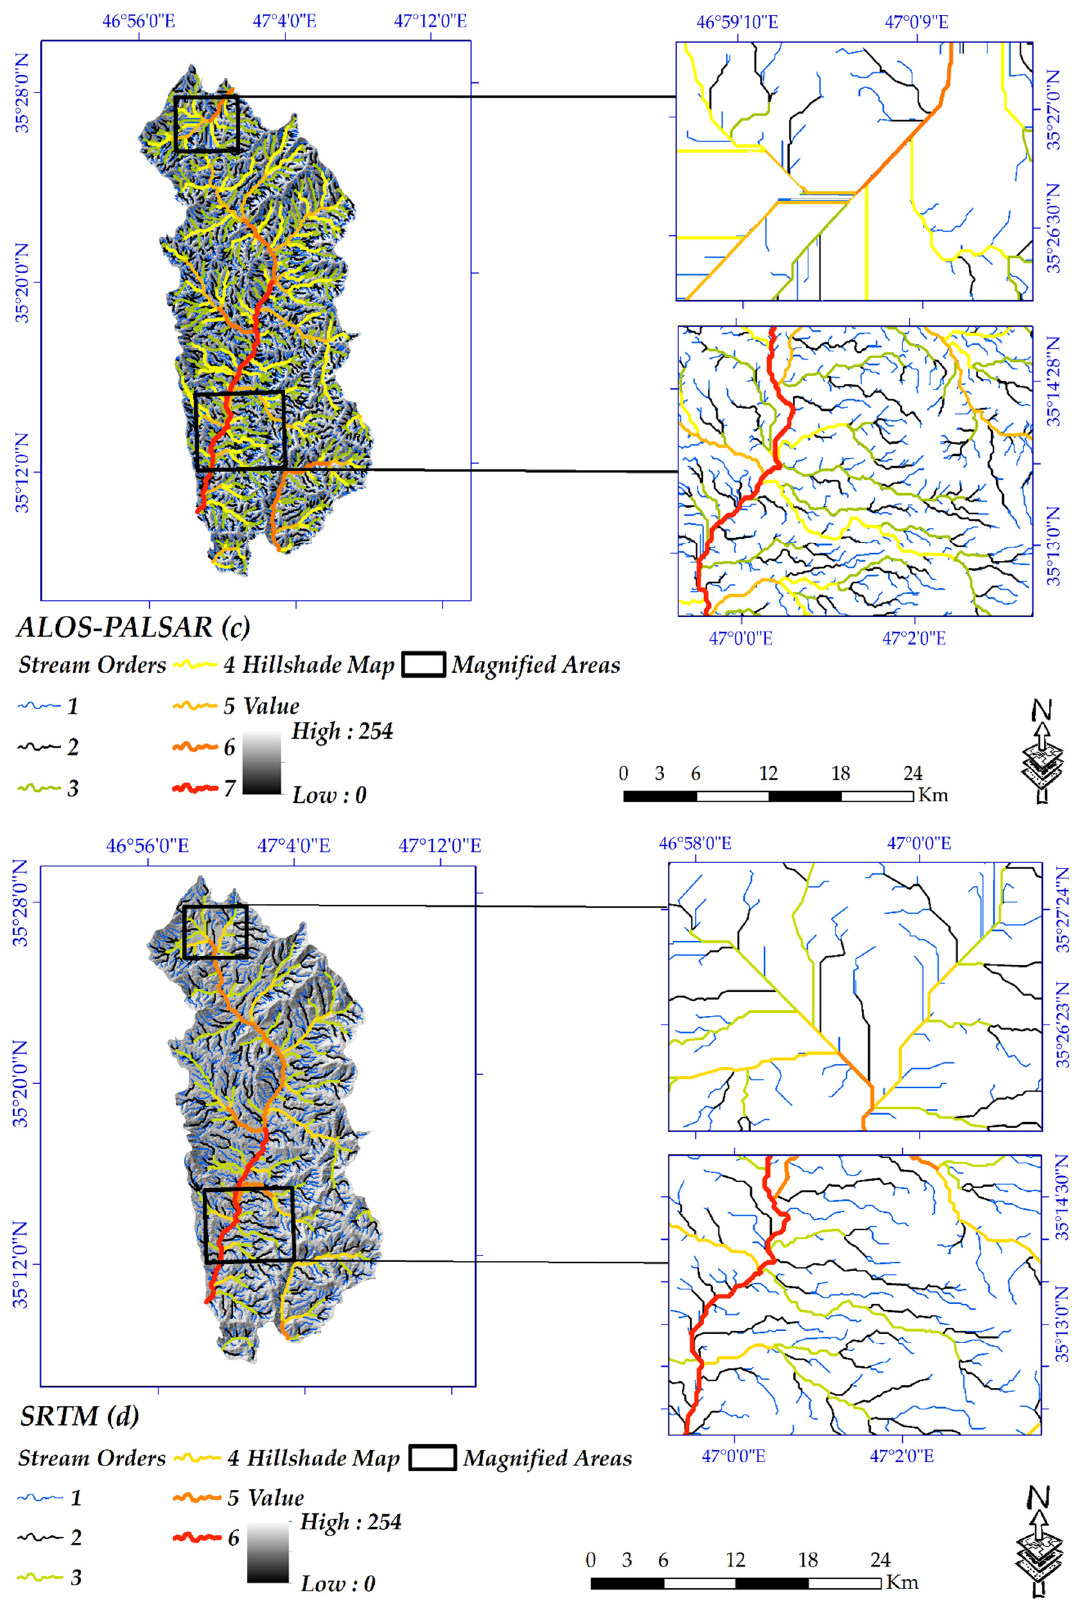
Figure 9. DEMs of ( a ) Sentinel-1; ( b ) TanDEM-X; ( c ) ALOS-PALSAR; and ( d ) SRTM.